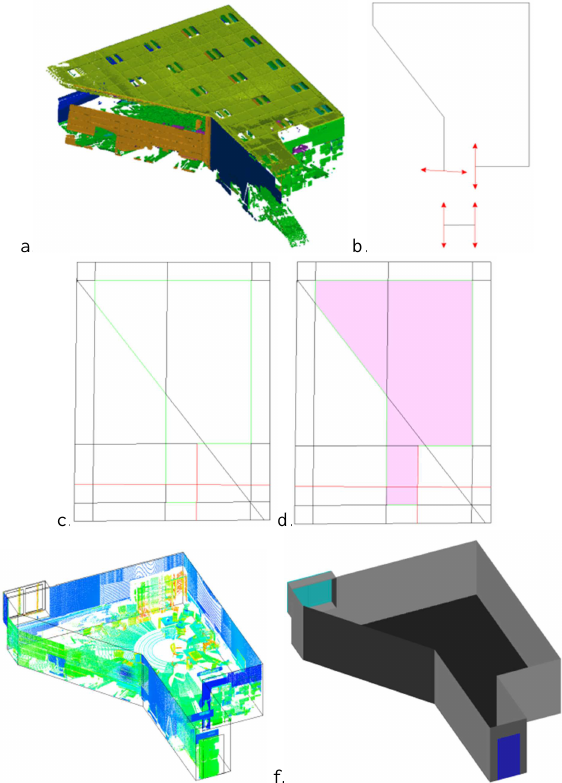
Figure 11. Geometric reconstruction of ‘Office’ data set: (a) segmentation results; (b) detected primitives with ‘pending’ walls; (c) induced cell complex ; (d) final ray-tracing labelling ; (e) wireframe model with overlaid the original point cloud; and (f) final 3D model.